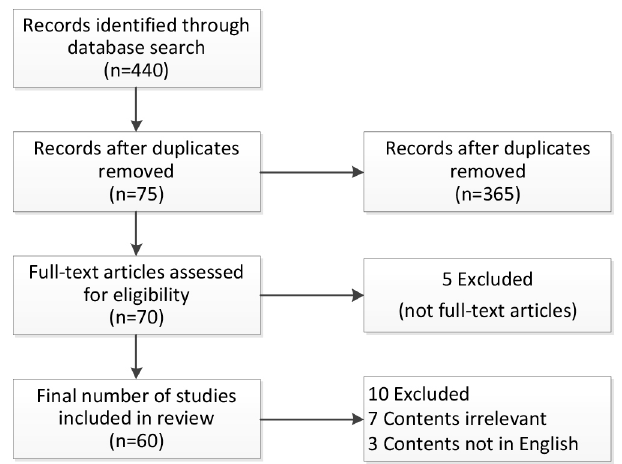
Figure 1. Flow Chart for Article